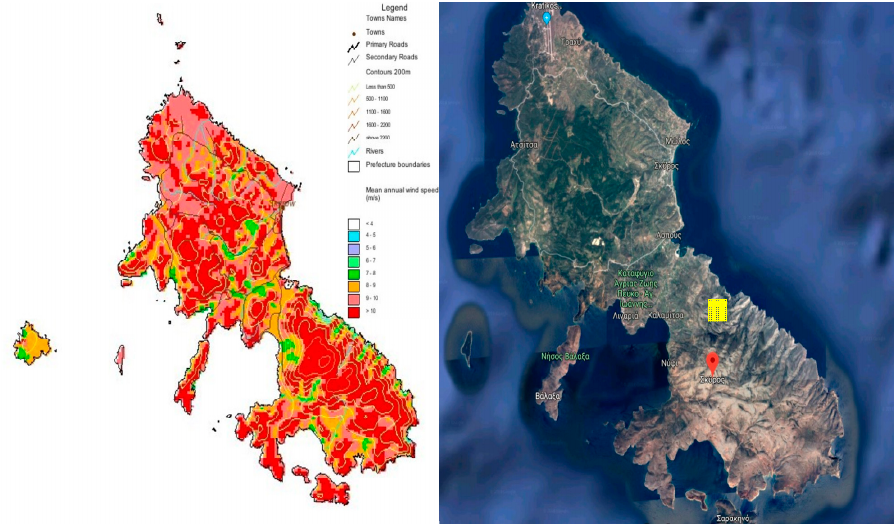
Figure 6. Wind data and geographic topology of Skyros island, Greece.